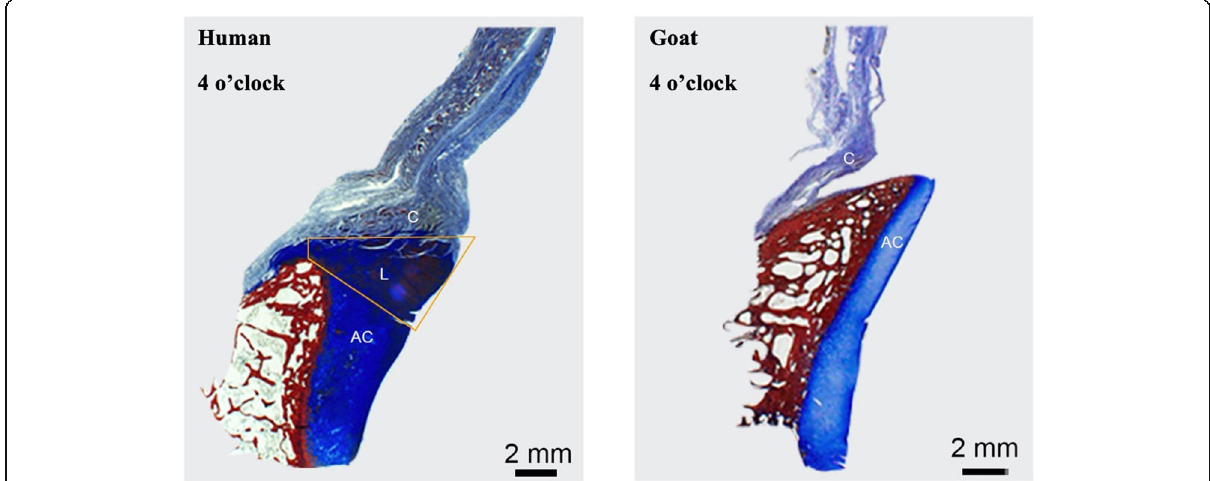
Fig. 6 Attachment site comparison between human (left) and goat (right) at 4 o ’ clock position, exemplifying the presence and absence of a discrete labral structure in humans compared to other animal species, respectively. Articular cartilage (AC), labrum (L), and capsule